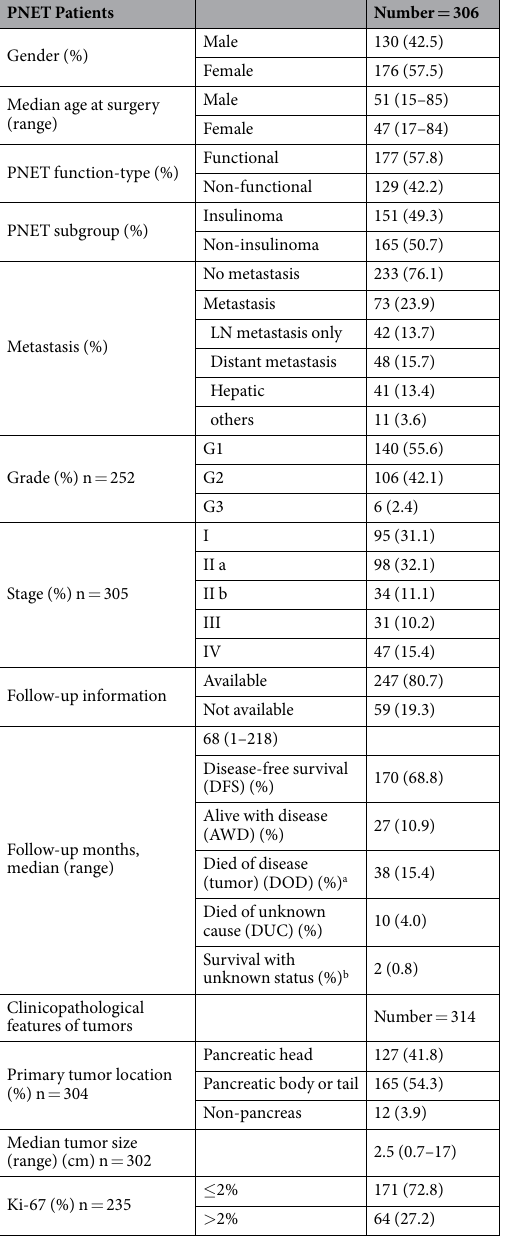
Table 1. Summary of Clinicopathological Features of PNET Patients. a One patient died of disease (tumor) but the survival time was unknown. b Two patients were alive but their disease status was